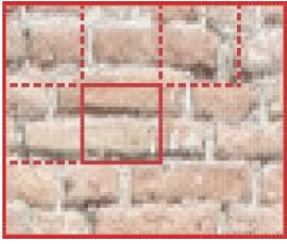
Figure 6. Illustration of the moving window mechanism to define the areas used for feature extraction from the training areas selected by the